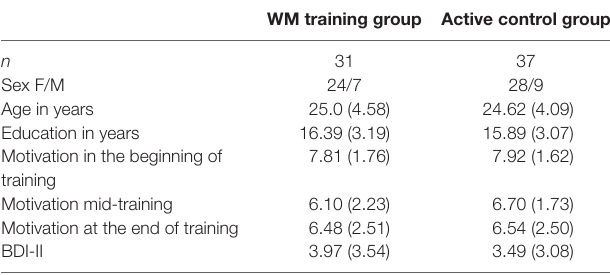
Table 1 | Descriptive data on the study